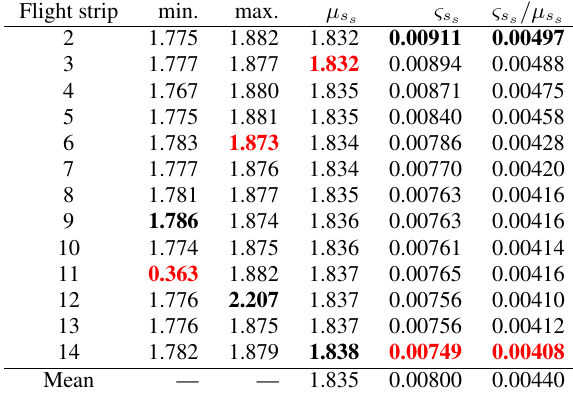
The average of the pulse widths s s in the 2005 campaign dif- fered about 1 . 5% from the average value of 2004 ( 1 . 835 ns vs. 1 . 861 ns ) with lower relative deviations. All flight strips showed very similar distributions, in contrast to the distributions of ˆ S (see Table 4 and Figure 5).